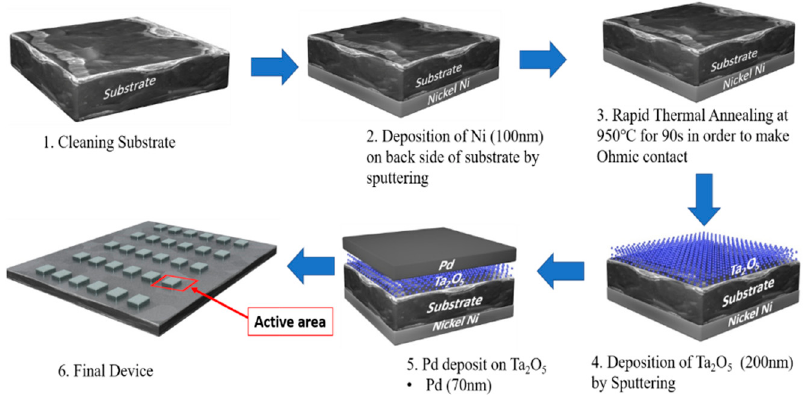
Figure 1. Fabrication procedure for the Pd/Ta 2 O 5 /SiC H 2 sensor device.